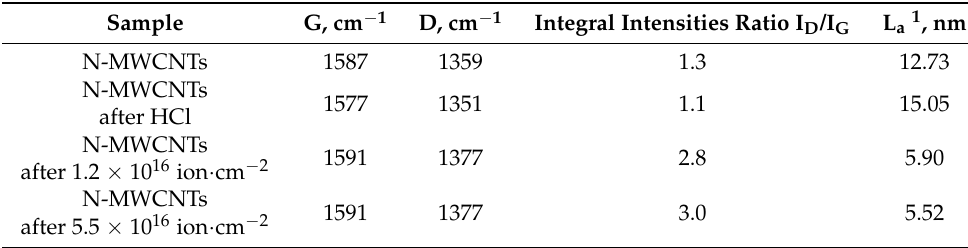
Table 1. D and G bands position and average crystallite size of the graphene sp 2 -carbon domains from the Raman spectra for the N-MWCNTs before and after treatments.